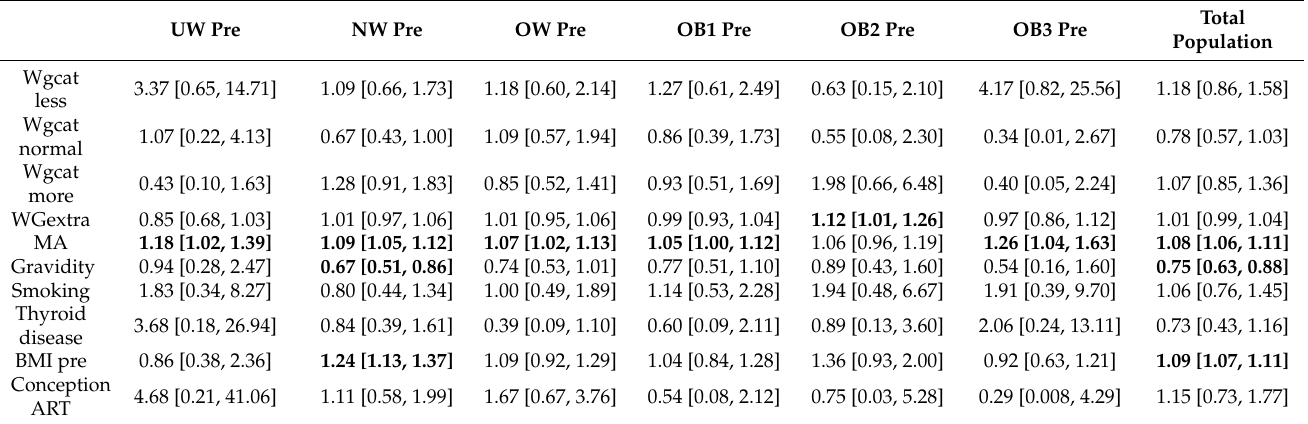
Table 6. Subgroup analyses for each BMI category before pregnancy, adjusted for MA, gravidity, smoking, thyroid disease, BMI pre, and